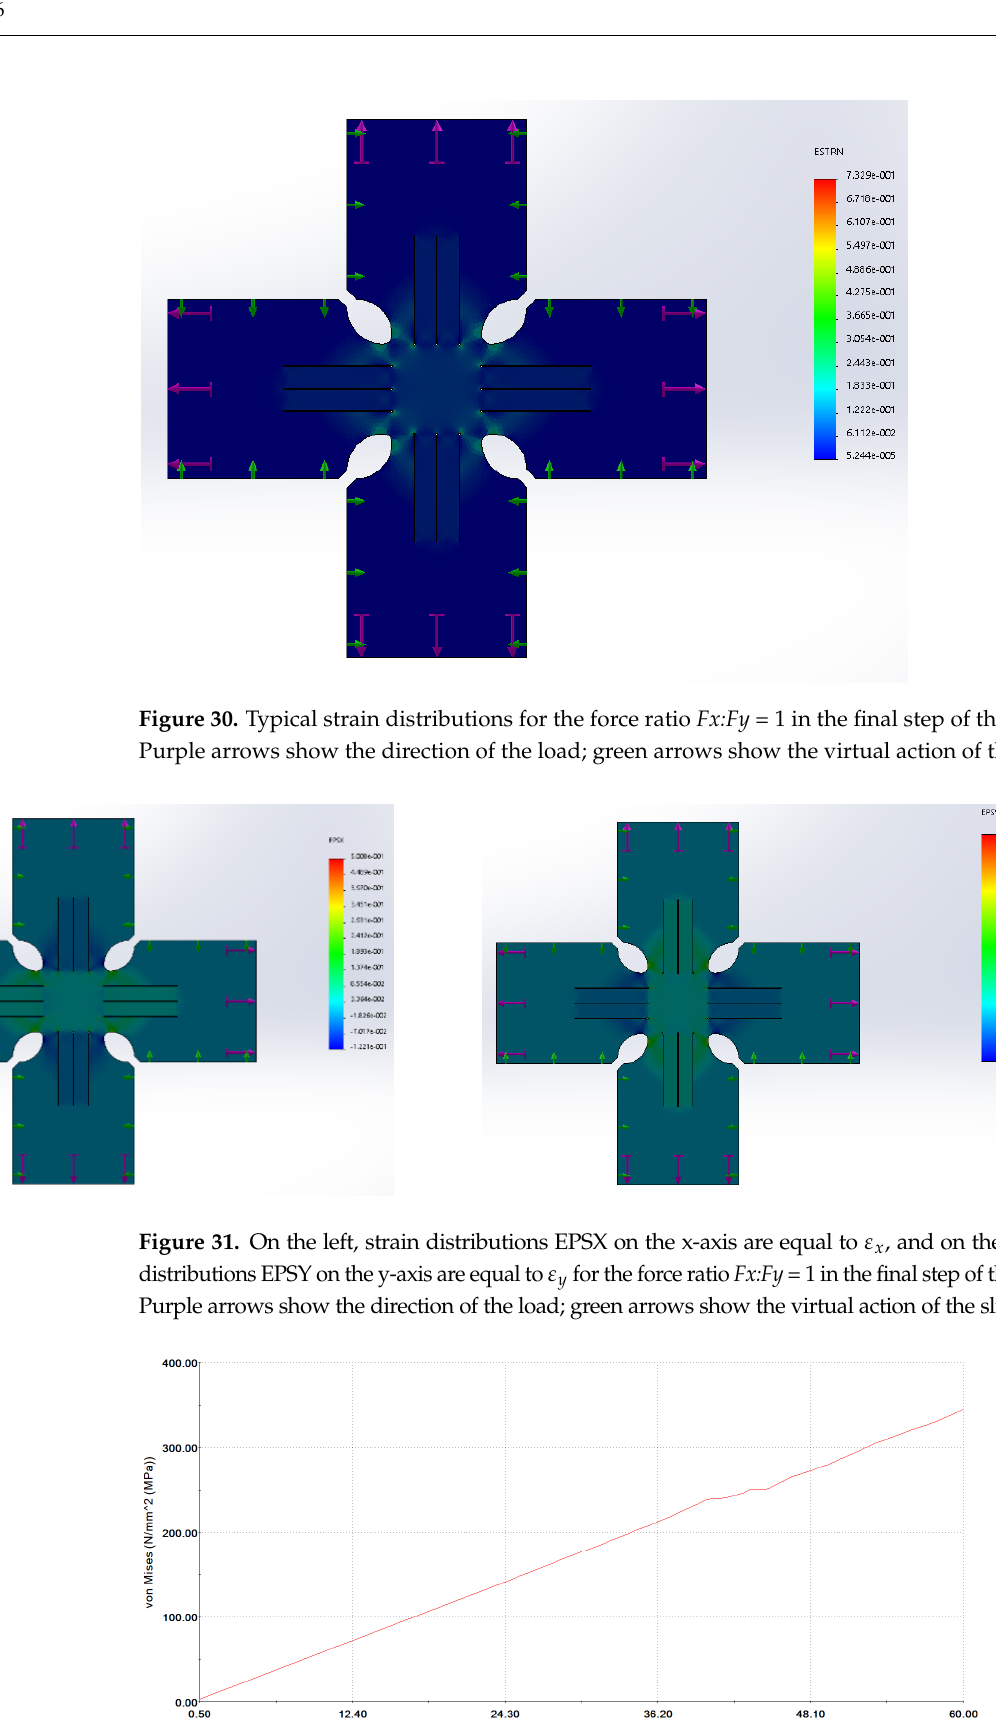
Figure 33. Graph of the change in the displacement in the node number 34331, reflecting the center of the cruciform specimen during the time in the simulation .